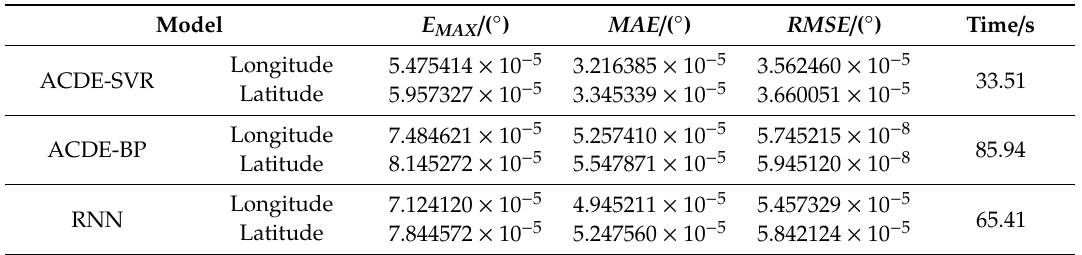
Table 6. Comparison of prediction error indicators between three trajectory prediction